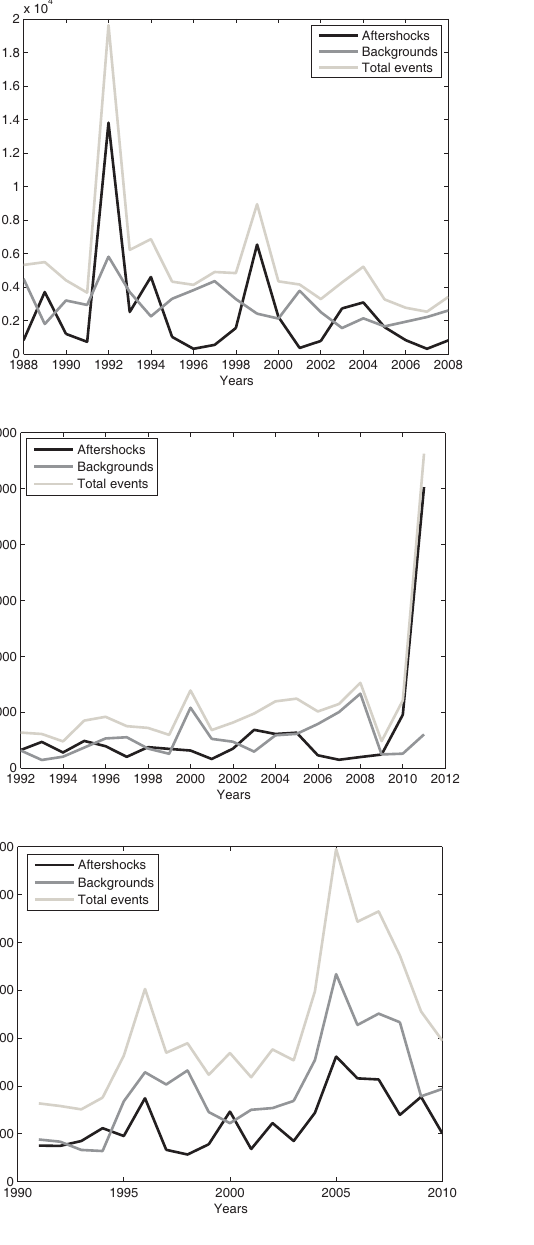
belong to Category 4 are taken as aftershocks. The events